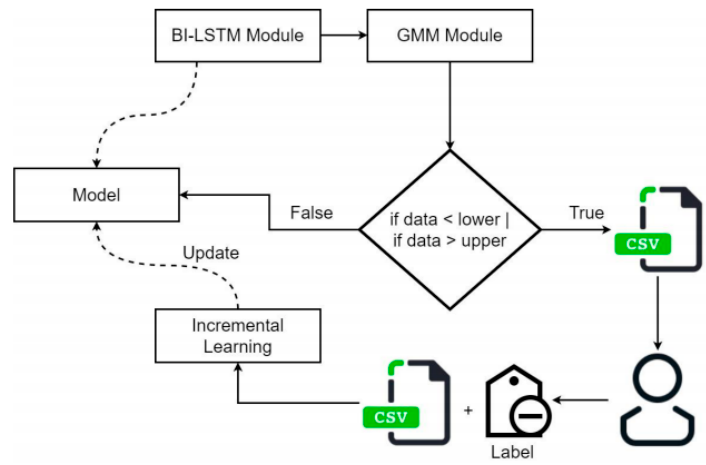
Figure 6. The control flow of the incremental learning procedure.